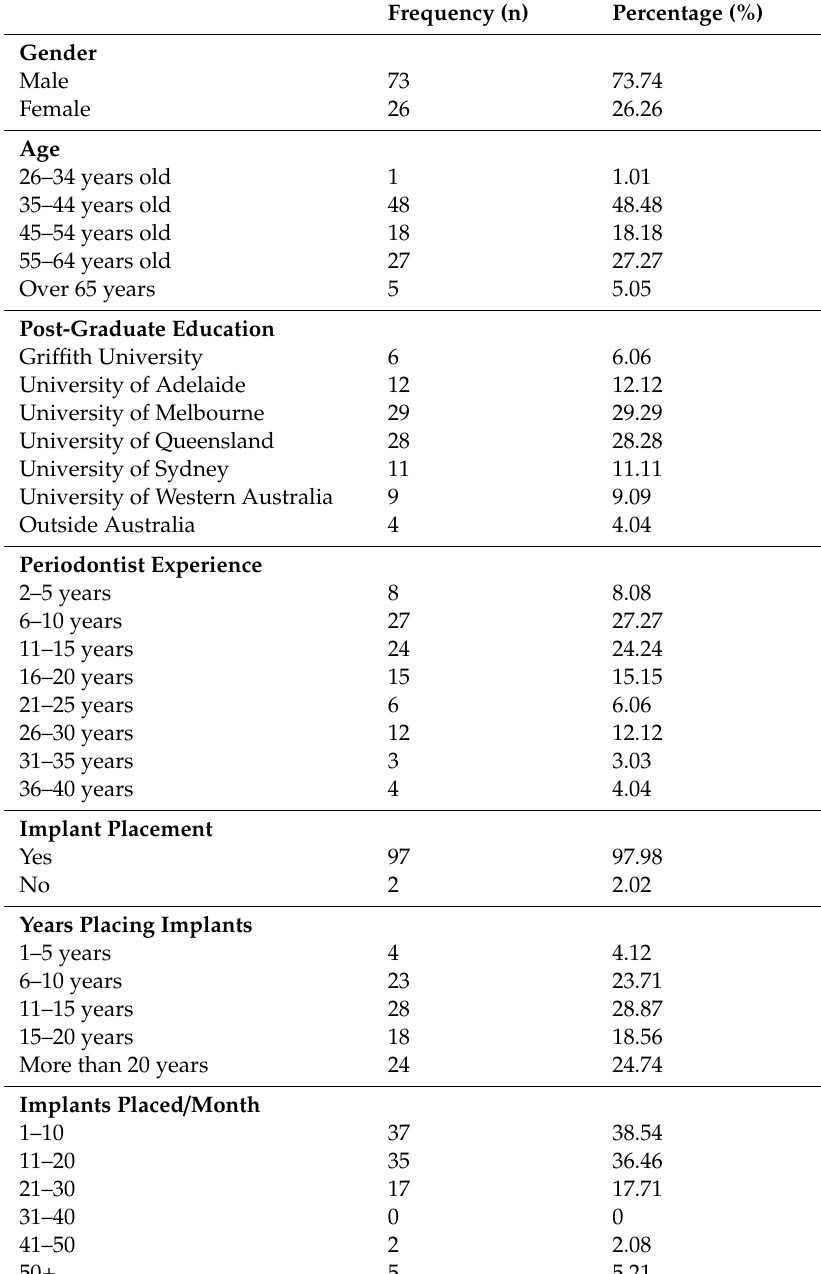
Table 1. Practitioners’ Demographics and Implant